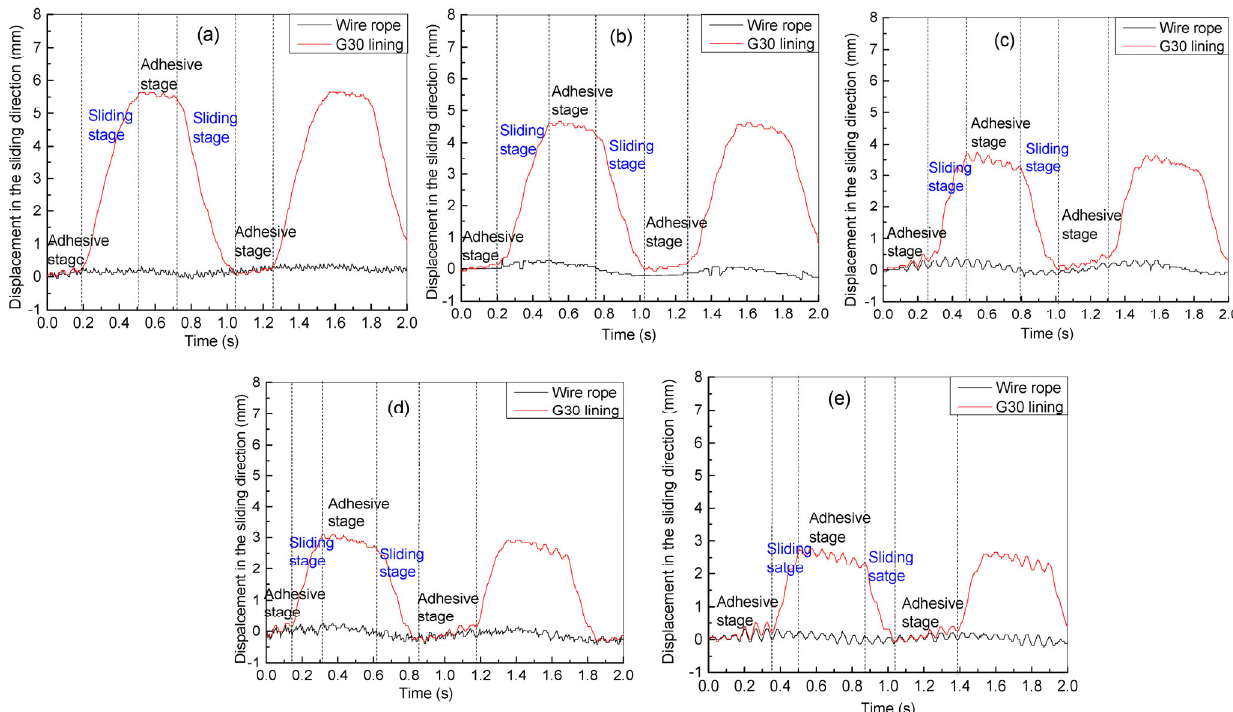
Fig. 6 Displacement of the G30 lining and wire rope in the sliding direction at: (a) 1, (b) 1.5, (c) 2, (d) 2.5, and (e) 3